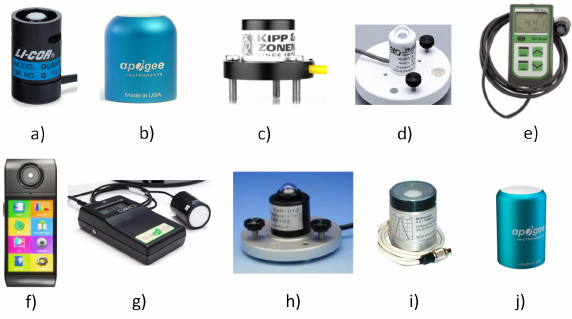
Fig. 13. Commercially-available PAR sensors from different manufacturers: a) LI-COR [19]; b) Apogee [20] ;